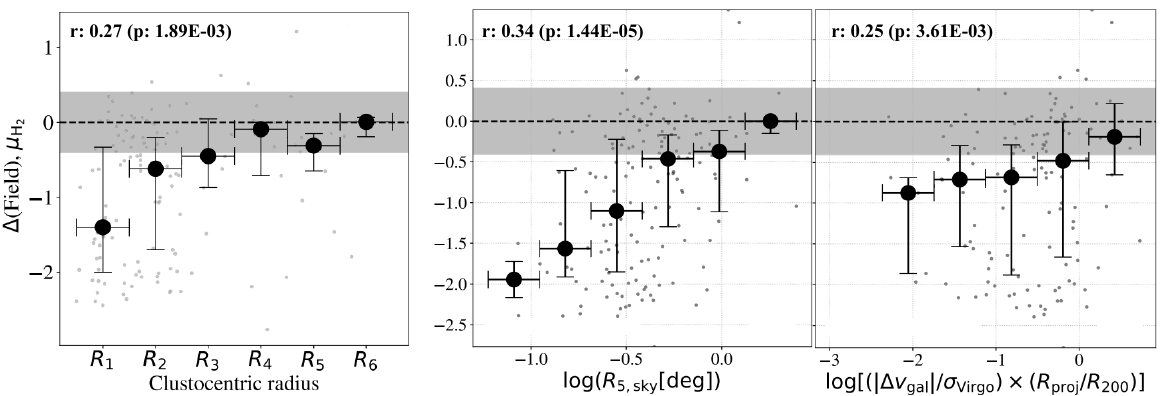
Figure 13. The radial trends of the molecular gas-to-stellar mass ratio ( M H / M (cid:63) ) for Virgo cluster 2 galaxies, where Mstar-dependencies of field galaxies have been subtracted to expose field offset quantities. The median values are plotted as large black circles, with individual points shown as gray circles. The dashed line at zero represents the field value with 1 σ uncertainties indicated by the shaded gray region. The Spearman’s rank order correlation coefficient and corresponding p-value are displayed in black text at the top of each panel. There is a trend toward larger offsets of molecular gas-to-stellar mass ratio with decreasing clustercentric radius (left panel), as well as with other environmental tracers, such as increasing projected local galaxy density (middle panel), and earlier accretion epoch (right panel). Figure adapted from Figures 6–8 in Morokuma-Matsui et al. [665], reproduced by permission of the